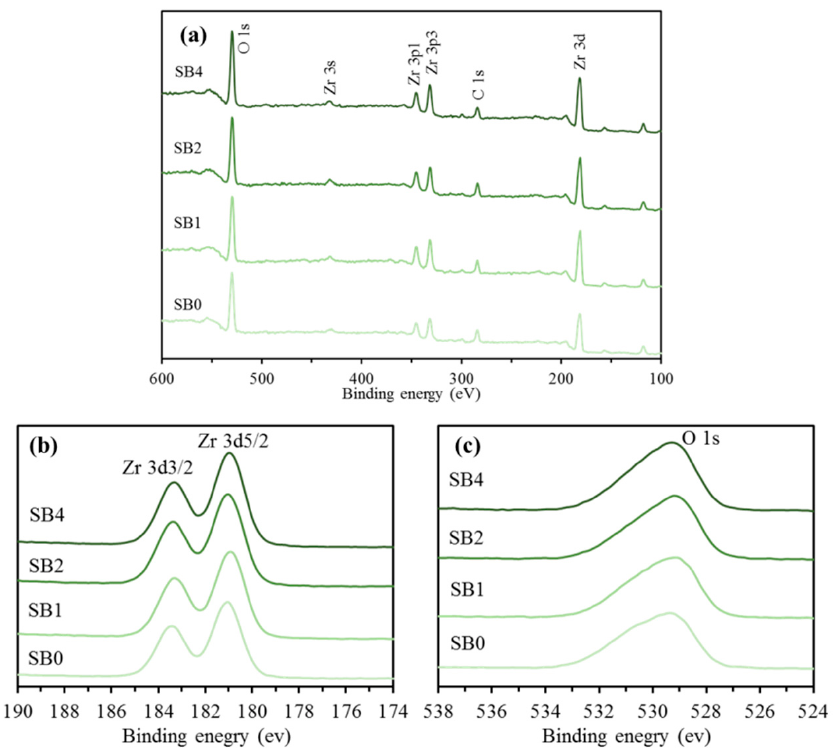
Figure 3. ( a ) XPS spectra of the Group SB specimen surfaces with different plasma treatments, and high-resolution XPS analyses of ( b ) Zr 3d and ( c ) O 1s.